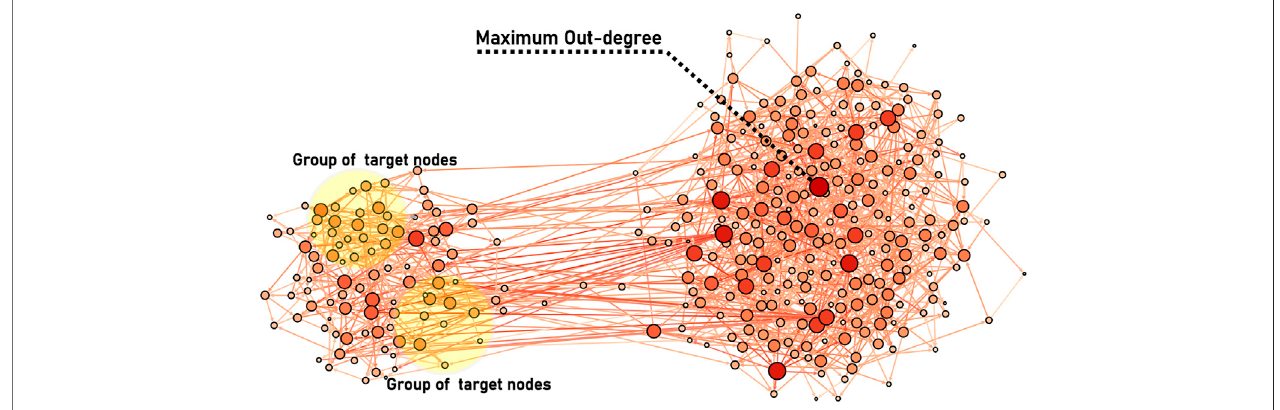
FIGURE1 | Illustrationofthe problem ofspreadingtowards localized targets in complexnetworks. The network isan arti fi cial network (350 nodes and 1,129 links) with two communities. The color (from dark red to white) of the nodes represents their respective degrees. Nodes in the yellow circle are the targets that need to be activated. The maximum out-degree node whose color is darkest is